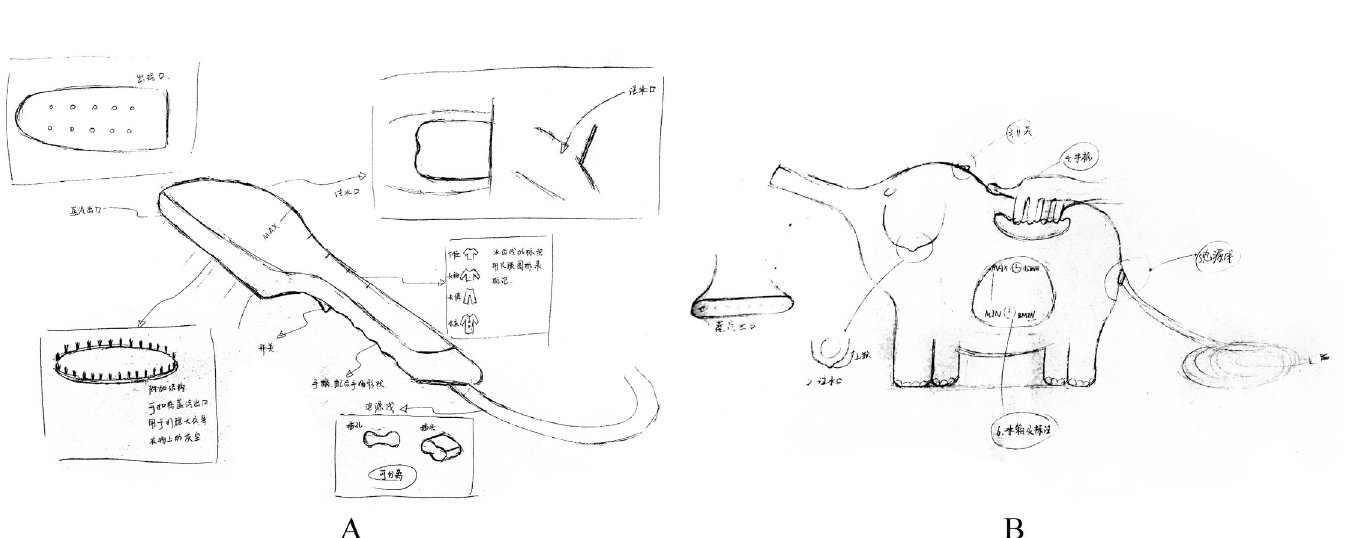
Fig 4. A High Degree of Originality in the Designs of the Two Groups (A: A design submitted from physical group; B: A design submitted from pictorial group).